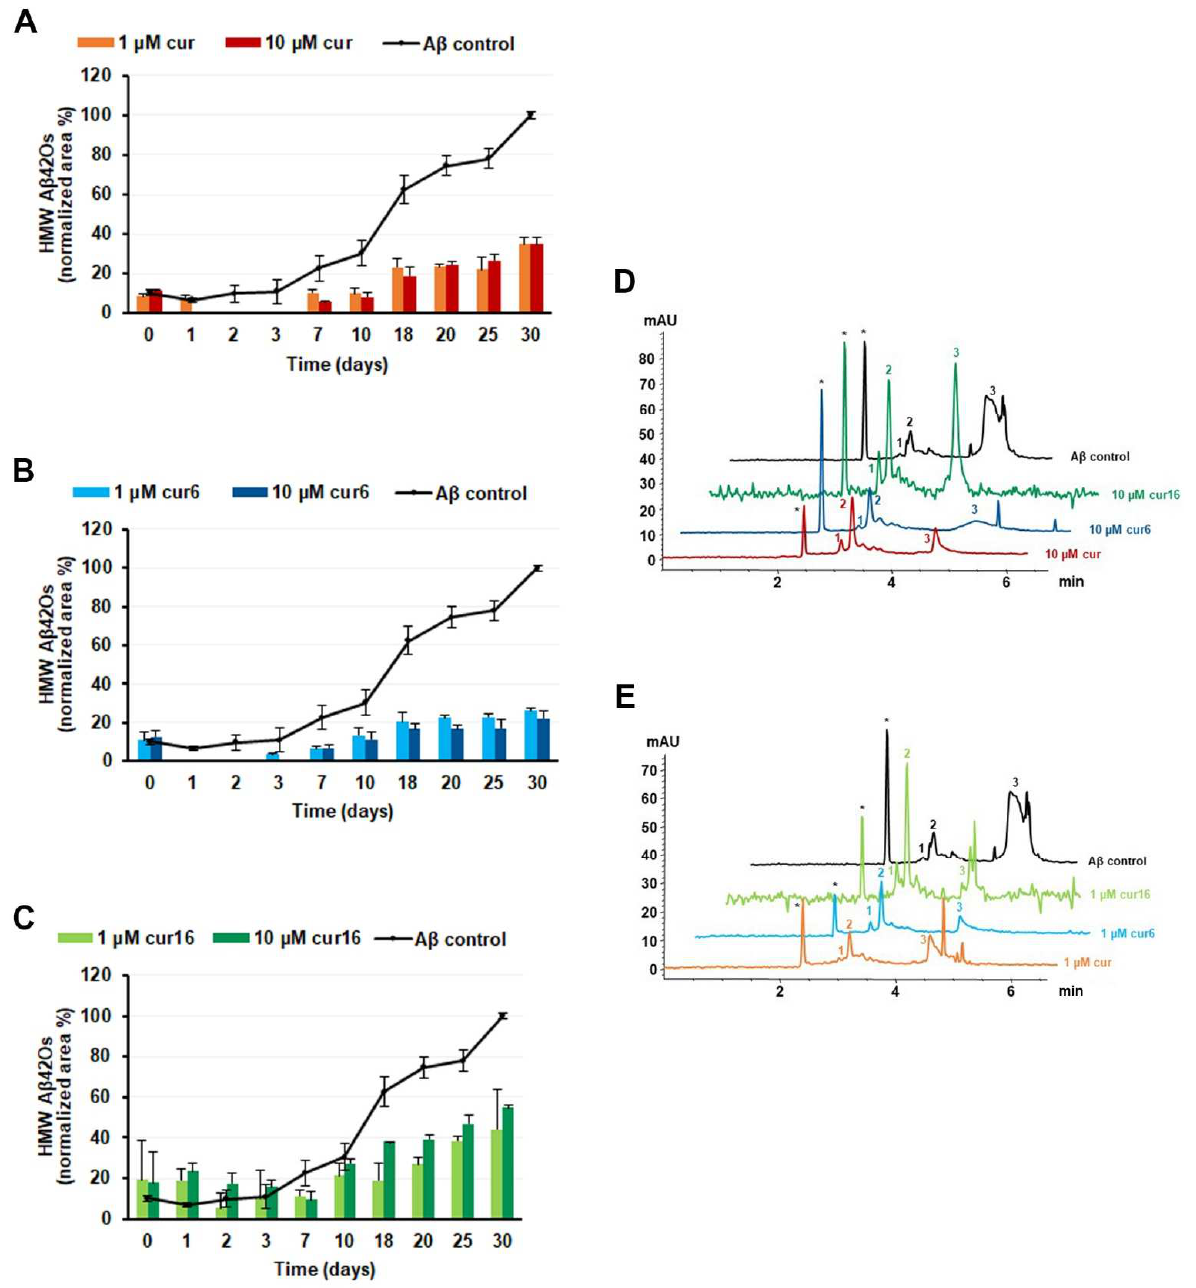
Figure 8. Effect of curcumin and analogues on A β 42 oligomerization. ( A – C ) Normalized area percentage plots of toxic HMW A β 42Os from a 221 µ M solution of A β 42 monomer, in the absence (control) and in the presence of decreasing concentrations of curcumin (cur, A ), cur6 ( B ) and cur16 ( C ). Data are expressed as mean ± standard deviation (n = 3). ( D , E ) Comparison among electropho- retic profiles of 221 µM Aβ42 control (black traces) and in the presence of 10 µM ( D ) and 1 µM ( E )